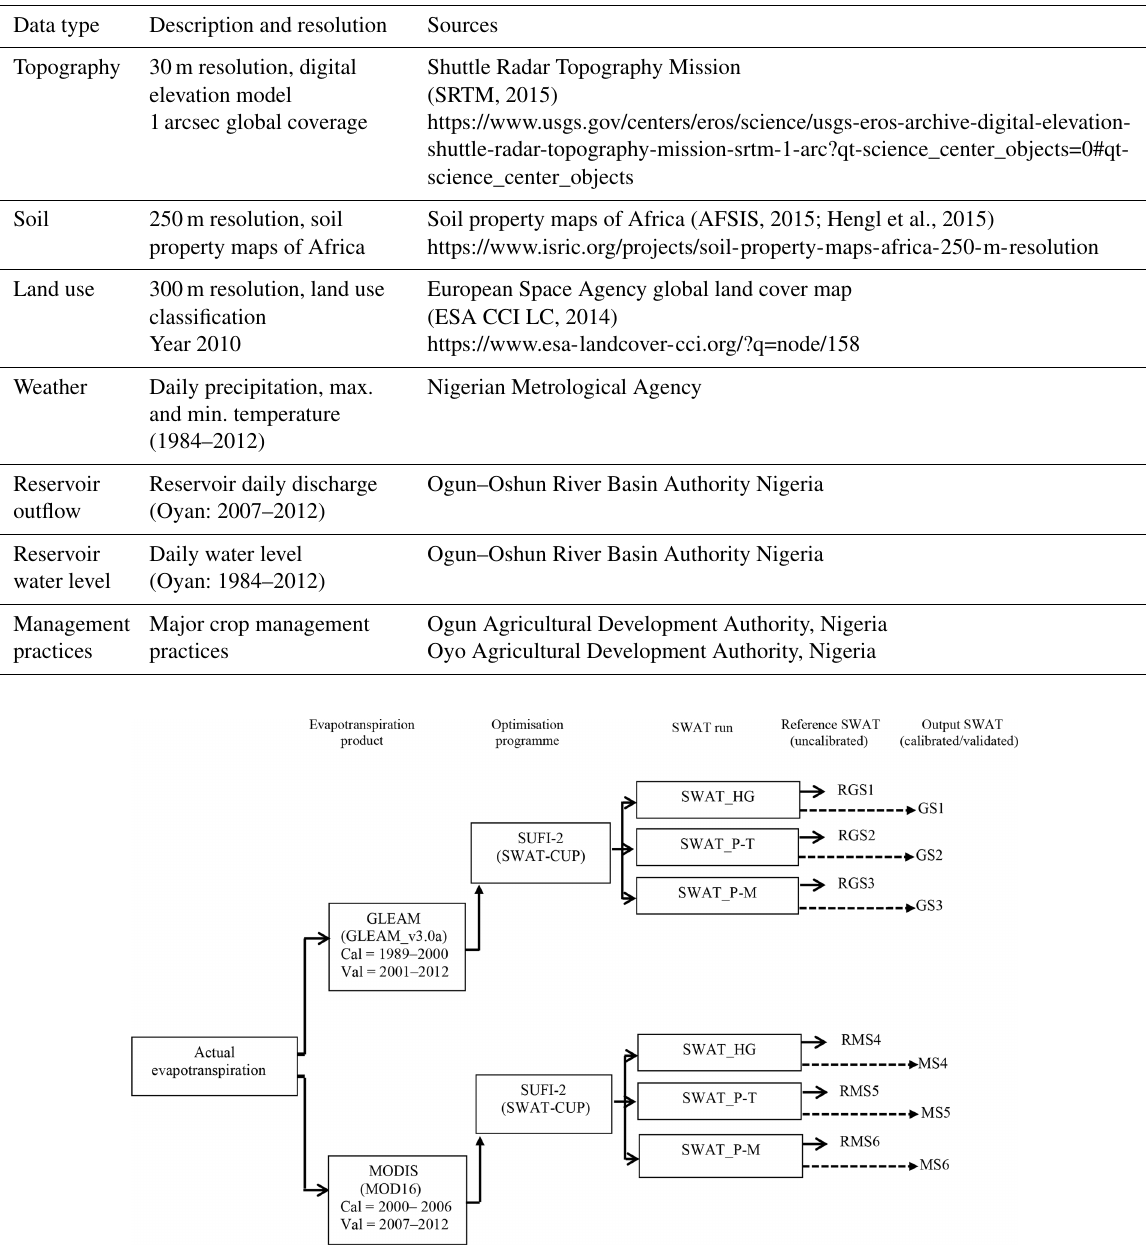
Table 1. Description and sources of input data used to configure the SWAT model for the Ogun River Basin. Data type